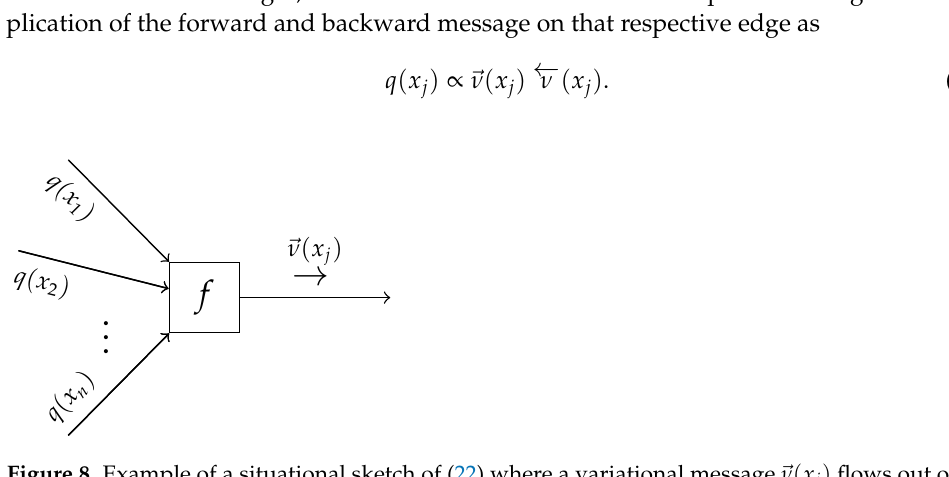
) flows out of an j